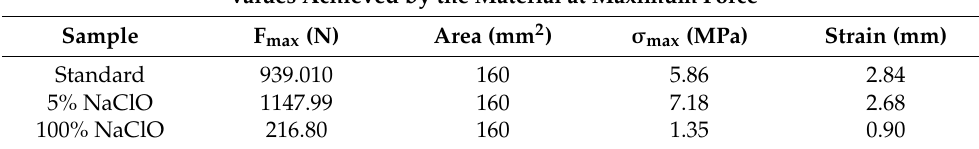
Table 7. Values achieved by beech at maximum force during tensile testing of the standard sample and samples immersed for three months in 5% and 100%